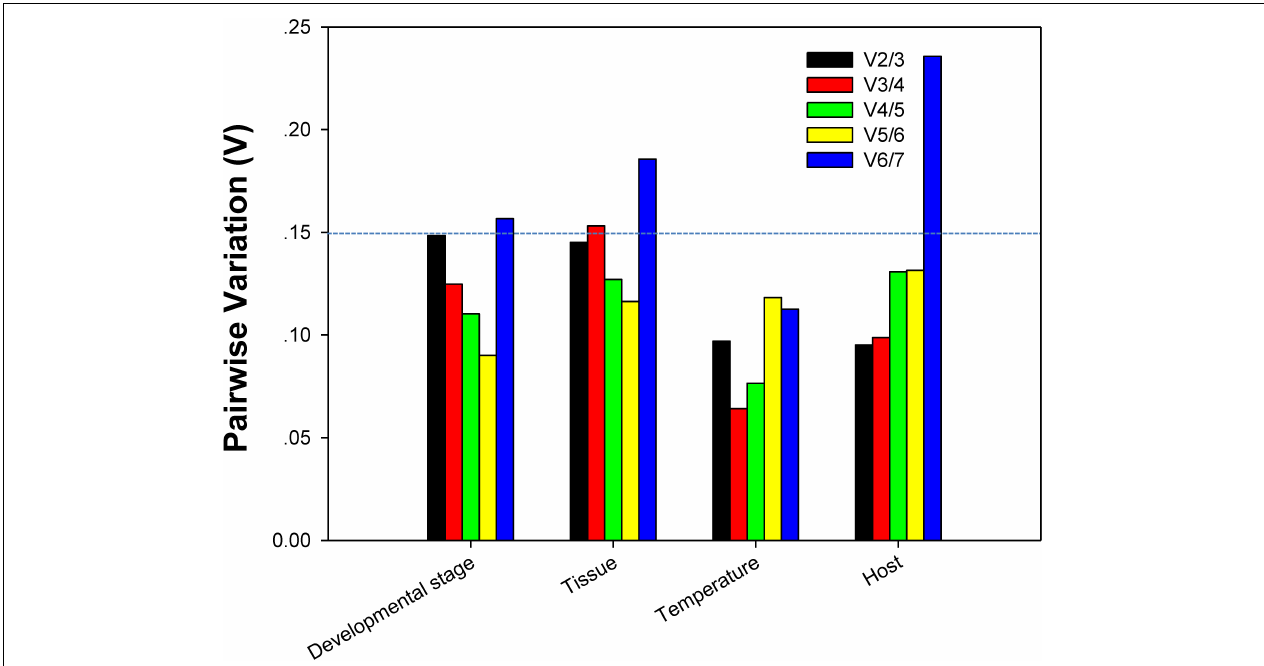
FIGURE 4 | Optimum number of reference genes required for accurate normalization of gene expression. Pairwise variation (V) values in the 4 groups using geNorm .